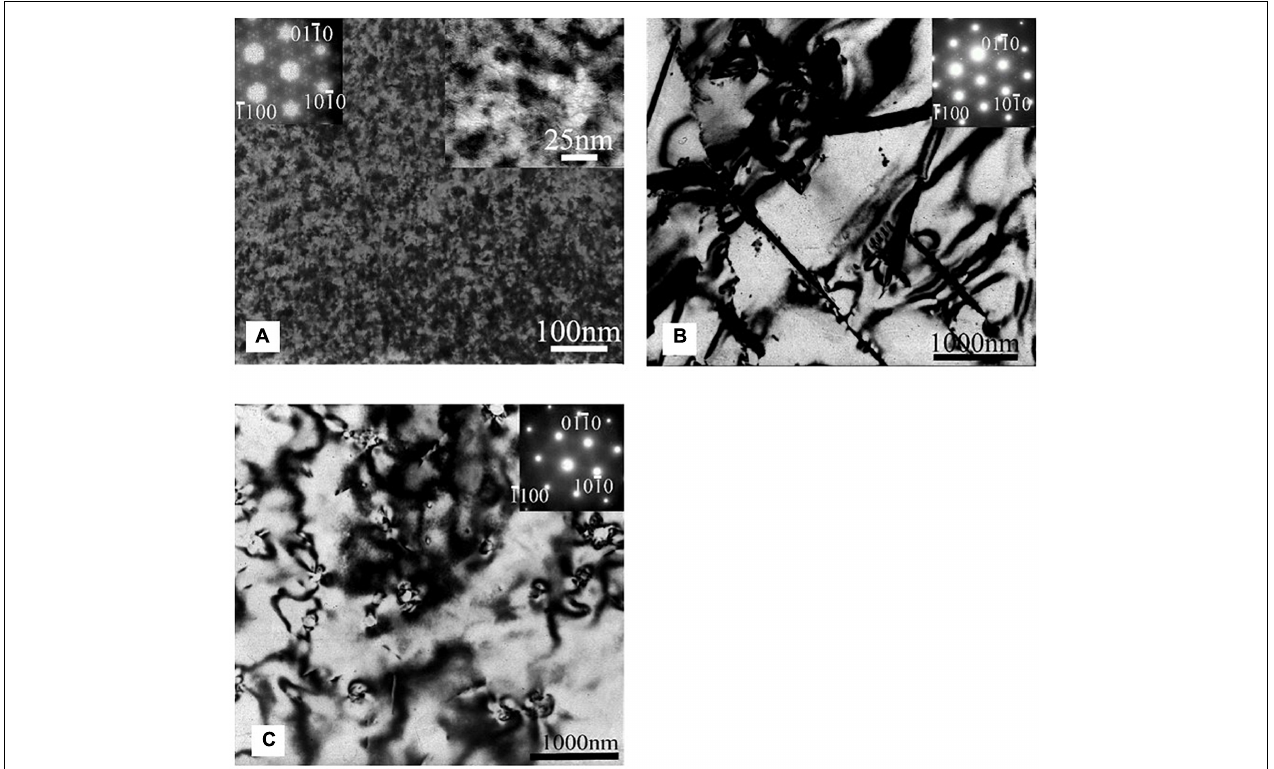
FIGURE 3 | TEM microstructures typical of Mg-10Gd alloy heat treated for 24 h at: (A) 200 ◦ C, (B) 300 ◦ C, and (C) 400 ◦ C. The electron beam direction is approximately parallel to [0001]Mg direction.